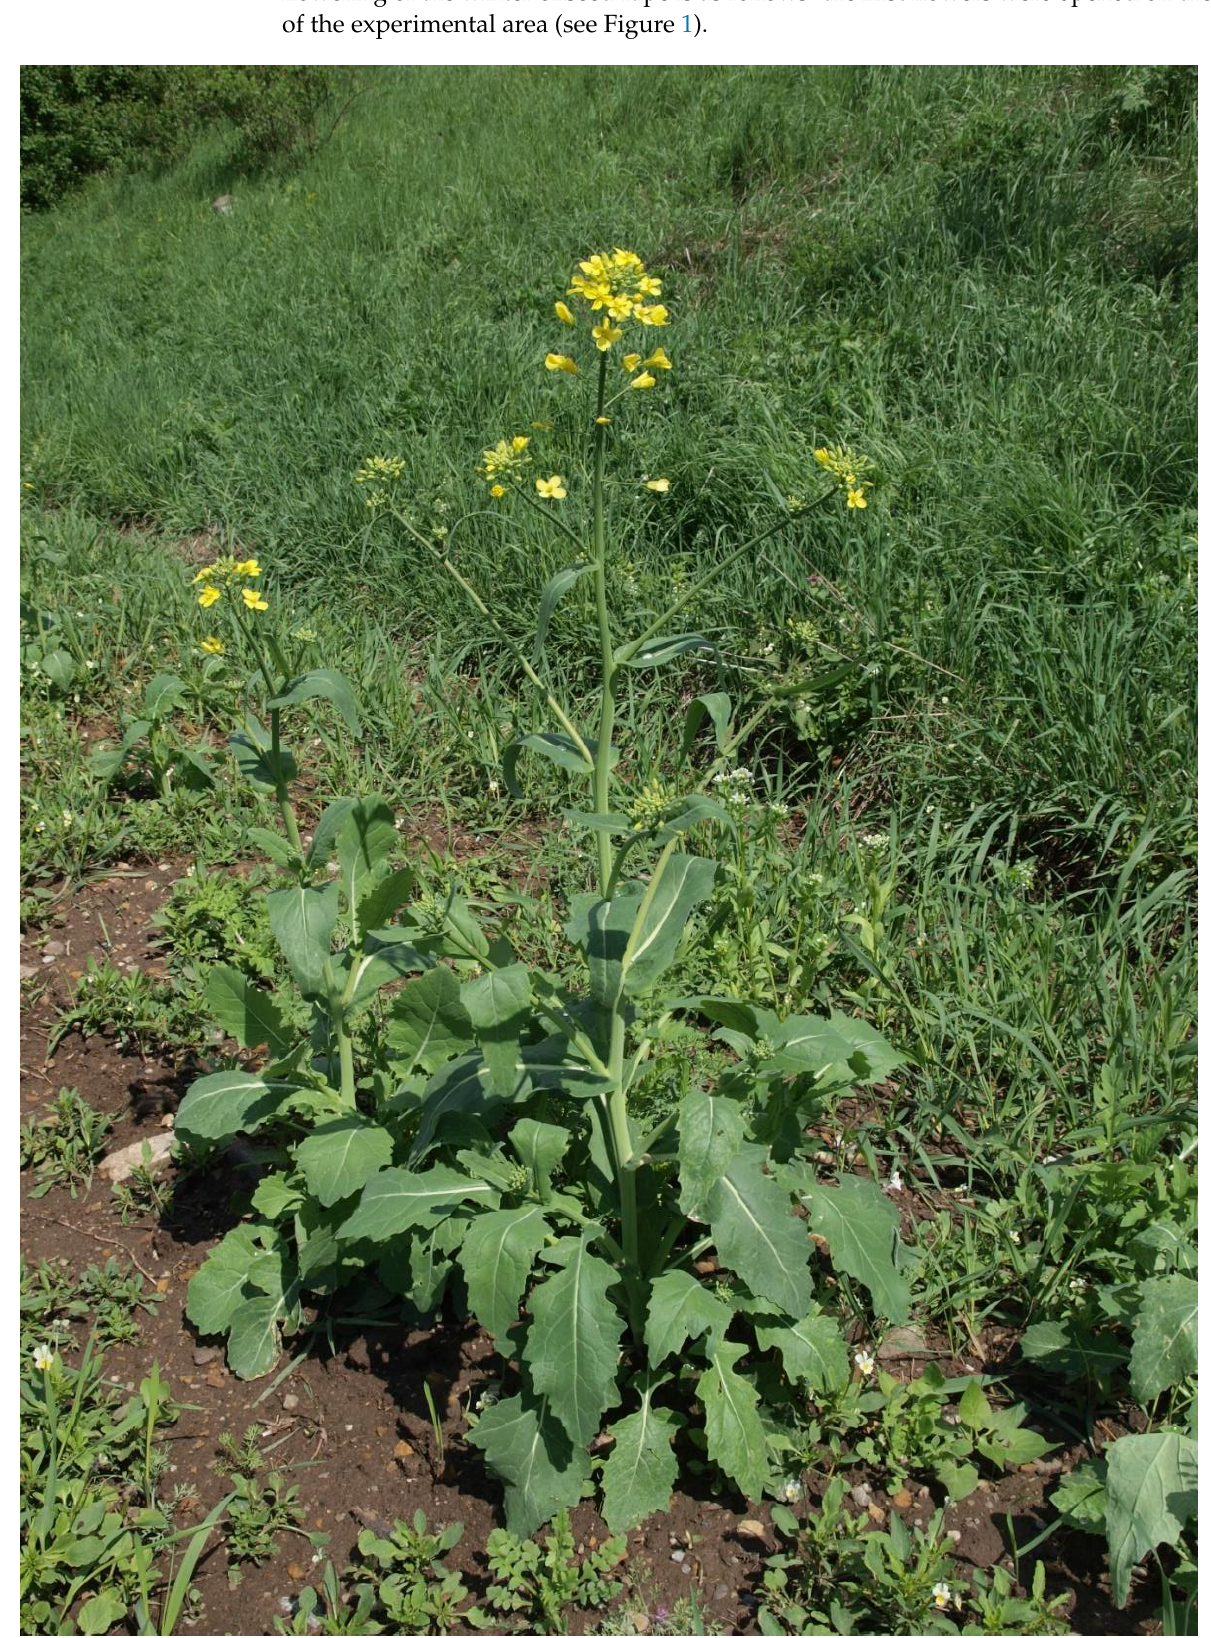
Figure 1. Beginning of flowering of the winter oilseed rape ( Brassica napus ).